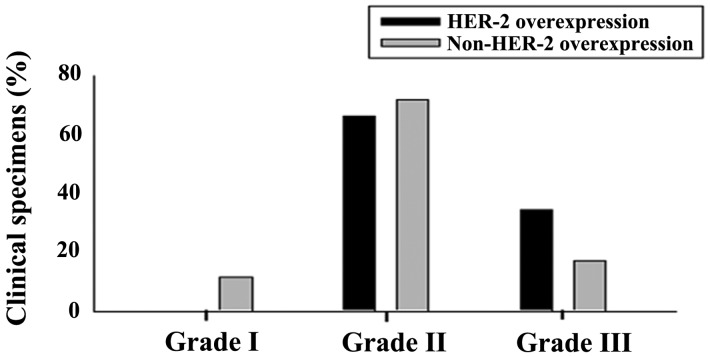
Representation of HER2-overexpressing and non-HER2-overexpressing specimens across tumor grades.